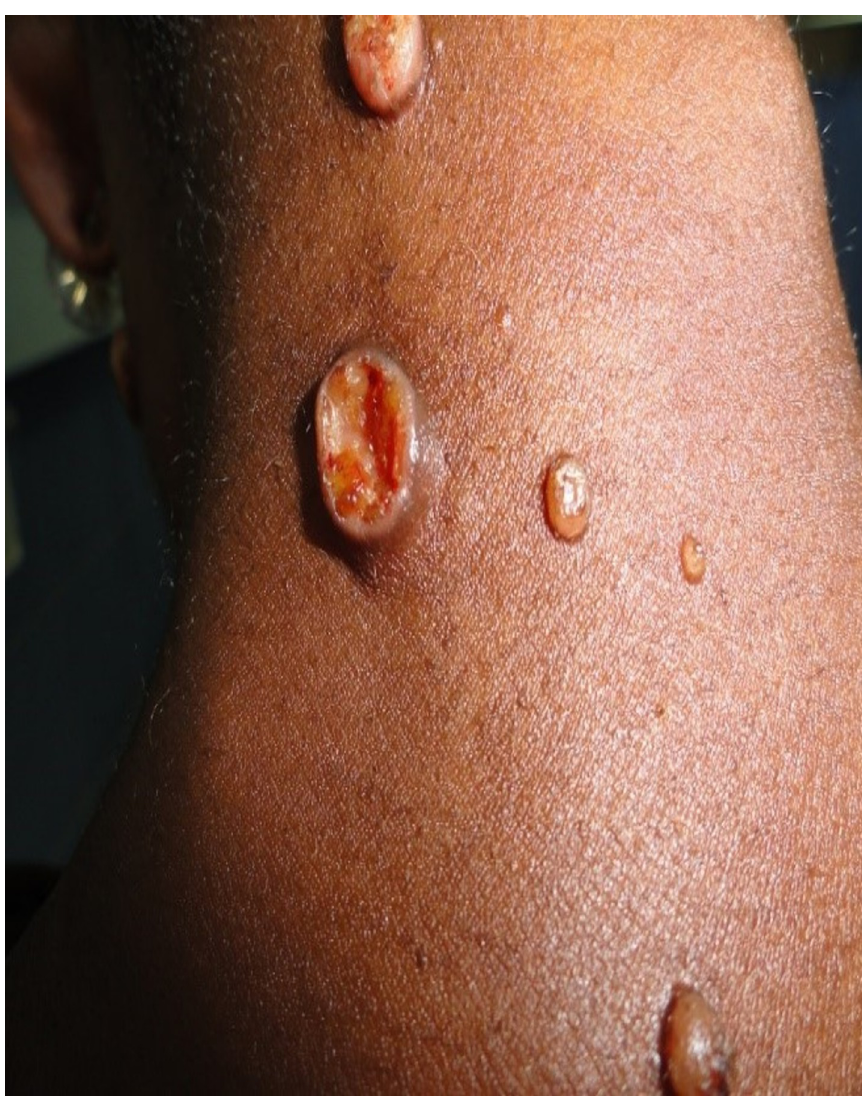
Fig 1. AU : PleasecheckwhethertheeditsmadetoFig 1 captionarecorrect ; andamendifnecessary : A 36-year-old HIV–negative female with variable sizes of fleshy nodules with umbilication and a well- demarcated scalloping ulcer.